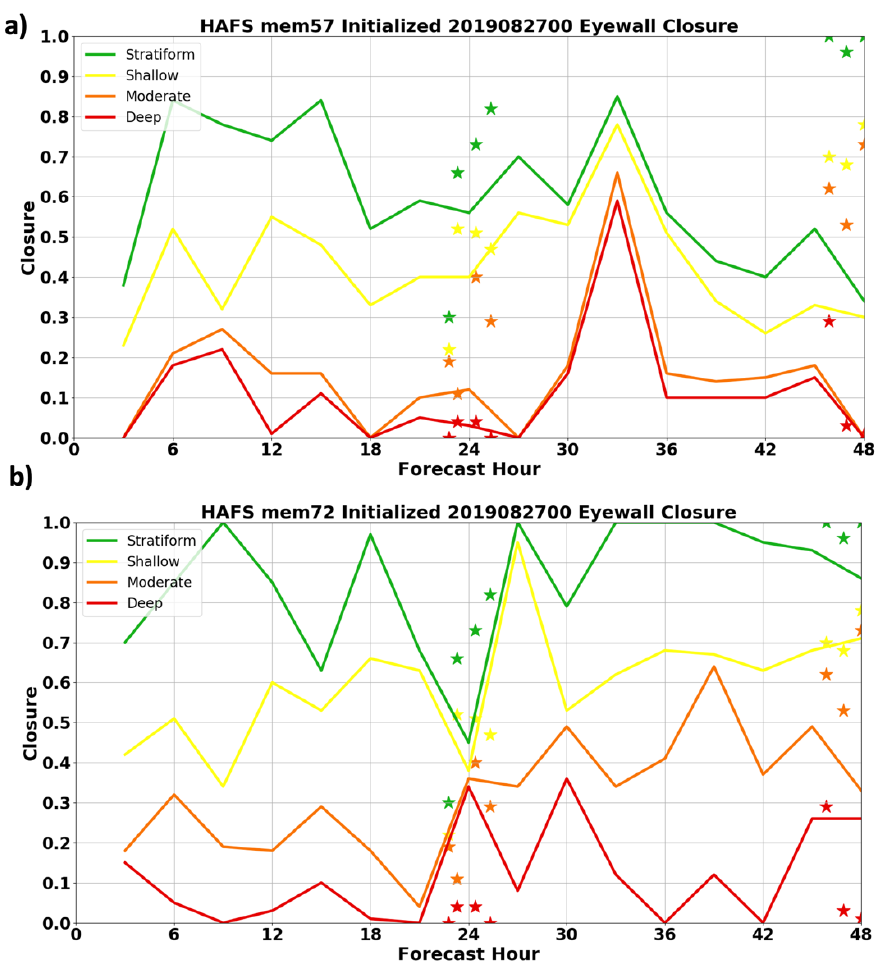
Figure 17. ( a ) Eyewall closure based on stratiform precipitation (green), shallow convection (yellow), moderate convection (orange), and deep convection (red) for the weak member from 3 to 48 h. The stars show the observed values from the NOAA P-3 radar data. ( b ) As in ( a ) but for the strong member.